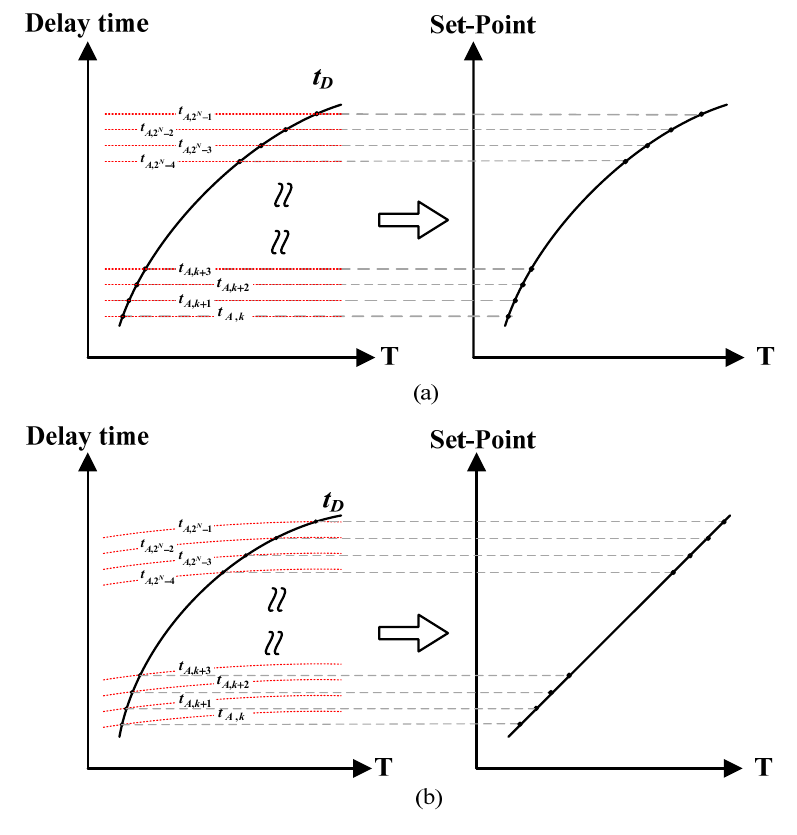
Figure 6. Linearity for ( a ) reference clock period and ( b ) curvature-compensating